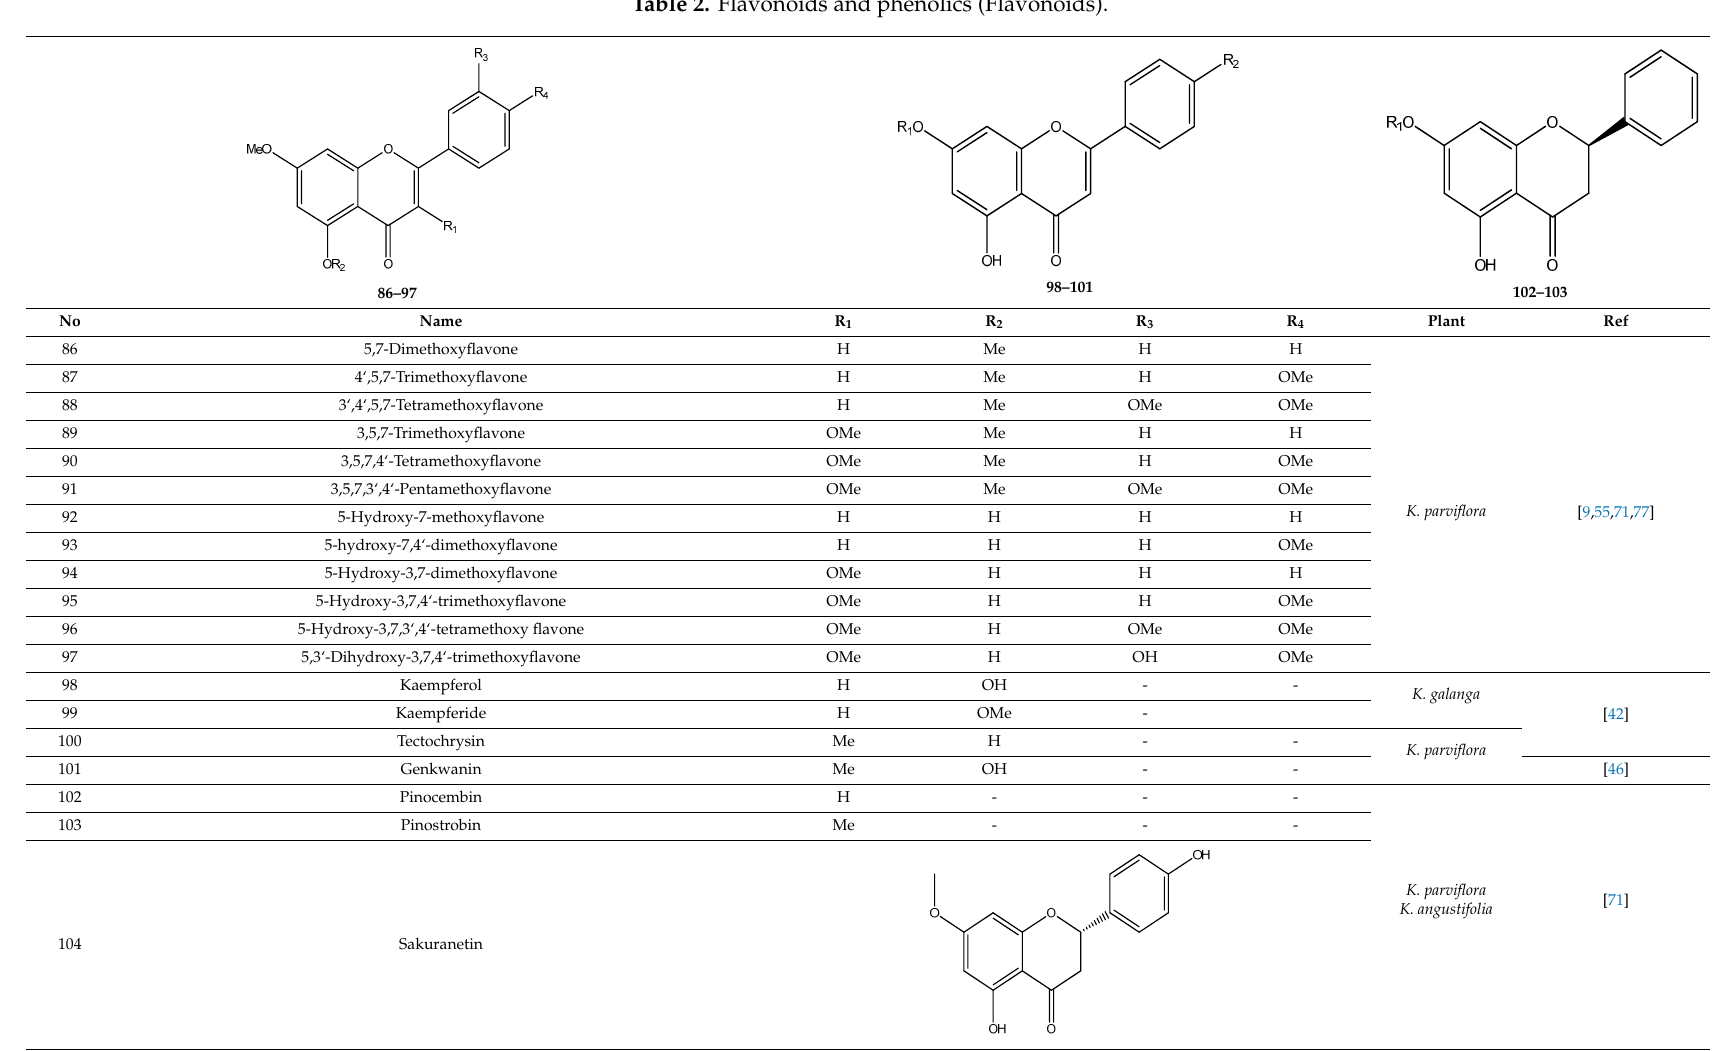
Table 2. Flavonoids and phenolics (Flavonoids).